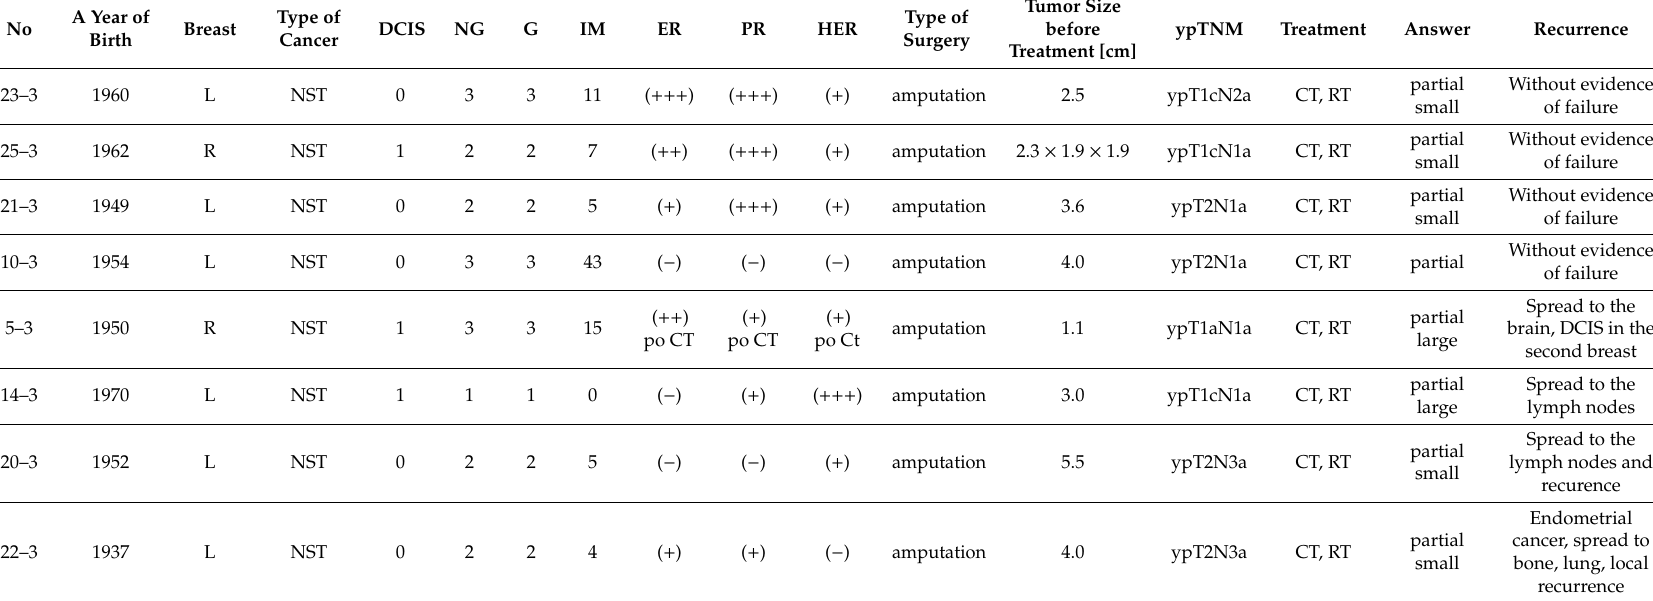
Table 2. Description of the samples, where “R” means right breast, “L”—left, “nst”—invasive carcinoma, DCIS (ductal carcinoma in situ)—formation of intraductal carcinoma, “NG”—nuclear grading, “G”—grading, “IM”—mitotic index, i.e., an amount of abnormal mitosis in 10 large fields of view, “ER”—status of the estrogen receptor ER (evaluated on one plus, two pluses and three pluses), “PR”—status of the progesterone receptor PR (evaluated on one plus, two pluses and three pluses), “HER”—status of HER-2 receptor (evaluated on one plus, two pluses and three pluses), only three pluses is a positive reaction, in “ypTNM” “y” means treatment, “p”—pathological evaluation, “T”—tumour size, “N”—state of the LN, “M”—information about the spread.